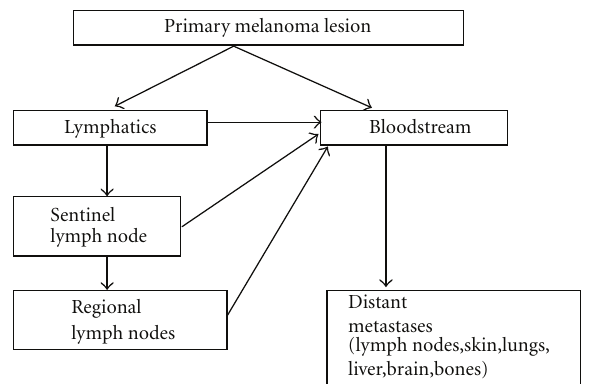
Figure 1: The process of metastasis is the consequence of migration of melanoma cells from the primary lesion, to locoregional and distant body sites via the lymphatic circulation and the blood- stream. Sentinel lymph node is the first draining lymph node in which melanoma cells may find a suitable environment and survive, leading to micro- or macrometastasis. If the cells spread hematogenously, distant metastasis will